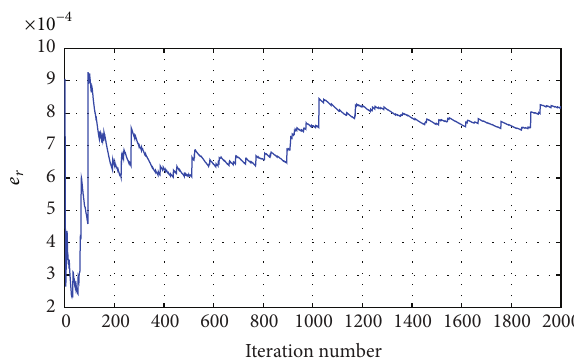
Figure 6: Error of two probabilities with